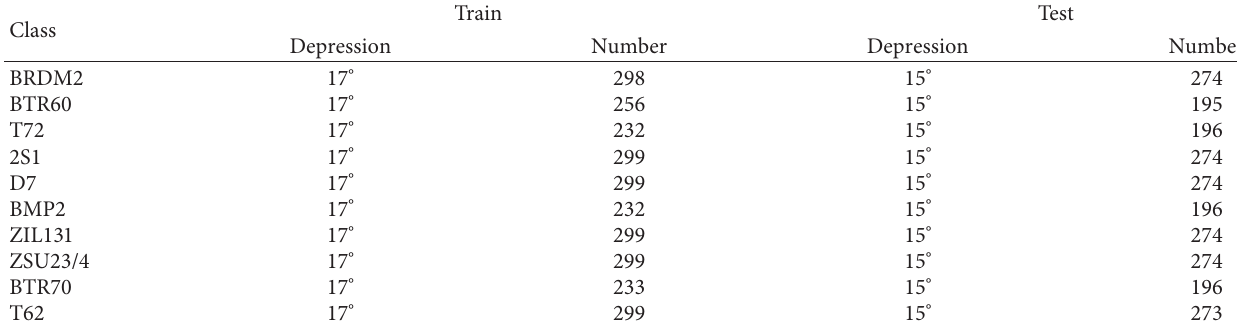
Table 1: Number of training and test samples for SOC.